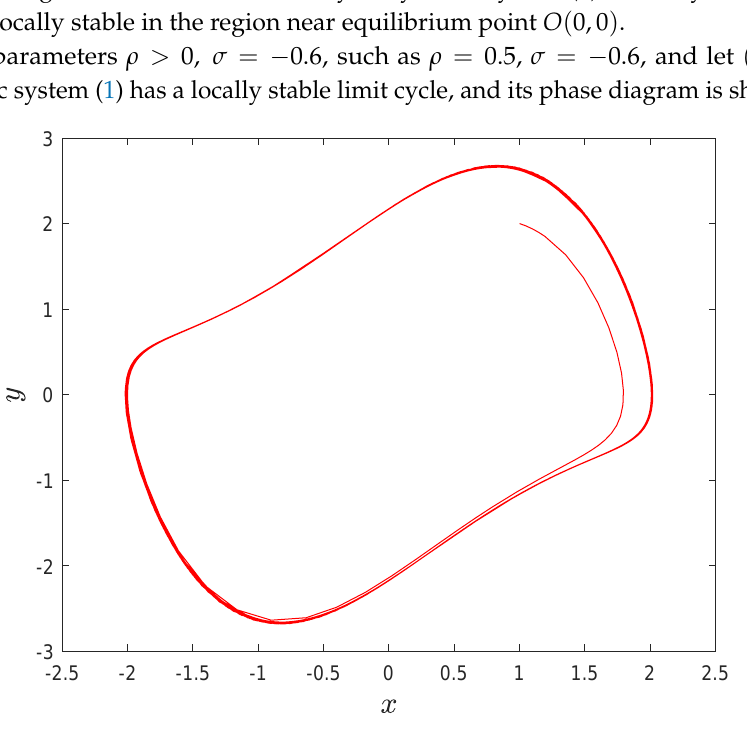
Figure 1. The phase diagram with initial values ( x 0 , y 0 ) = ( 1,2 )